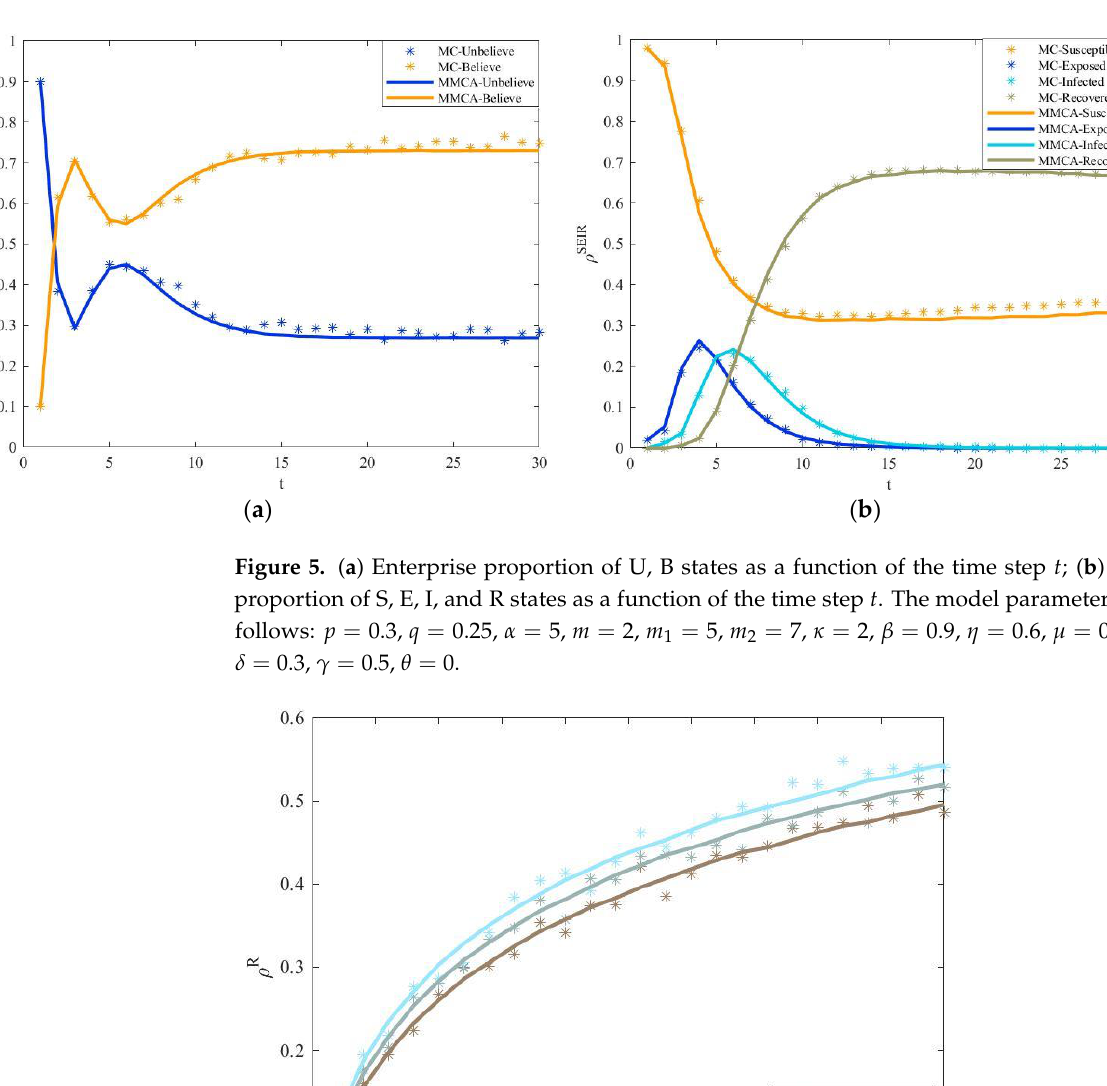
Figure 5. ( a ) Enterprise proportion of U, B states as a function of the time step t ; ( b ) Enterprise proportion of S, E, I, and R states as a function of the time step t . The model parameters are set as follows: